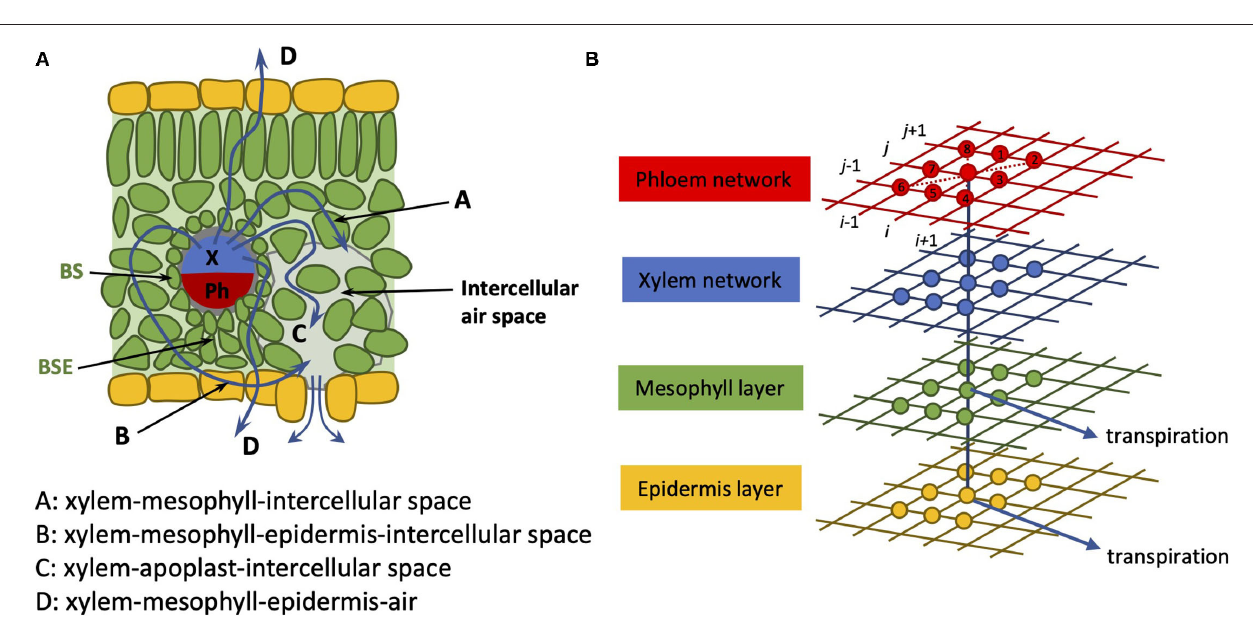
FIGURE 2 | (A) Cartoon of leaf anatomy in cross-section; (B) Coupled 2D networks of tissue pathways. The xylem network (blue grid) is connected on the one hand to a phloem network (red grid) and on the other hand to an epidermis network (yellow grid) through a (mesophyll network) (green grid). Transpiration (blue arrows) is assumed to occur through both the epidermis network and through the mesophyll network. As in our earlier article, the nodes are numbered in a grid-like fashion: ( i , j ) = (1,1) ... ( N , M ), as indicated by the black numbering. The identities of nearest and next-nearest neighbor nodes to node ( i , j ) are identified at the leaf creation stage and recorded for later recall. The flow occurs between nearest and next-nearest neighbor